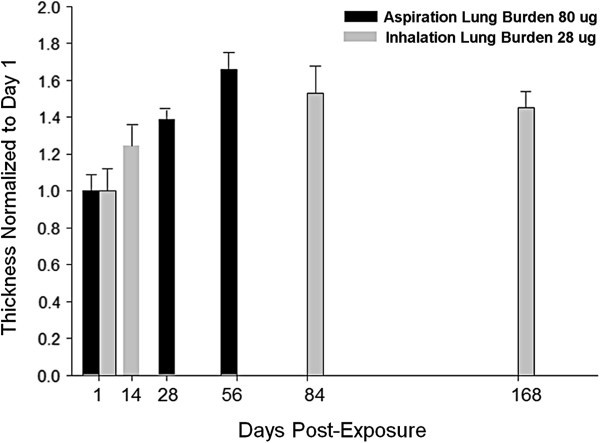
Comparison of fibrillar collagen response to inhaled versus bolus aspiration of MWCNTs. Although the total lung burden of these two routes differs by a factor of approximately 3, the time course and magnitude of response to bolus aspiration and inhalation exposure of MWCNT to the lungs are remarkable similar. Therefore, the fibrogenic potency of inhaled MWCNTs is approximately 3-fold greater than aspirated MWCNT (bolus exposure) on an equivalent lung burden basis. Fibrillar collagen response data following bolus aspiration exposure to MWCNTs from Mercer et al. [7], Figure 6 (Mean ± S.E., N = 6).